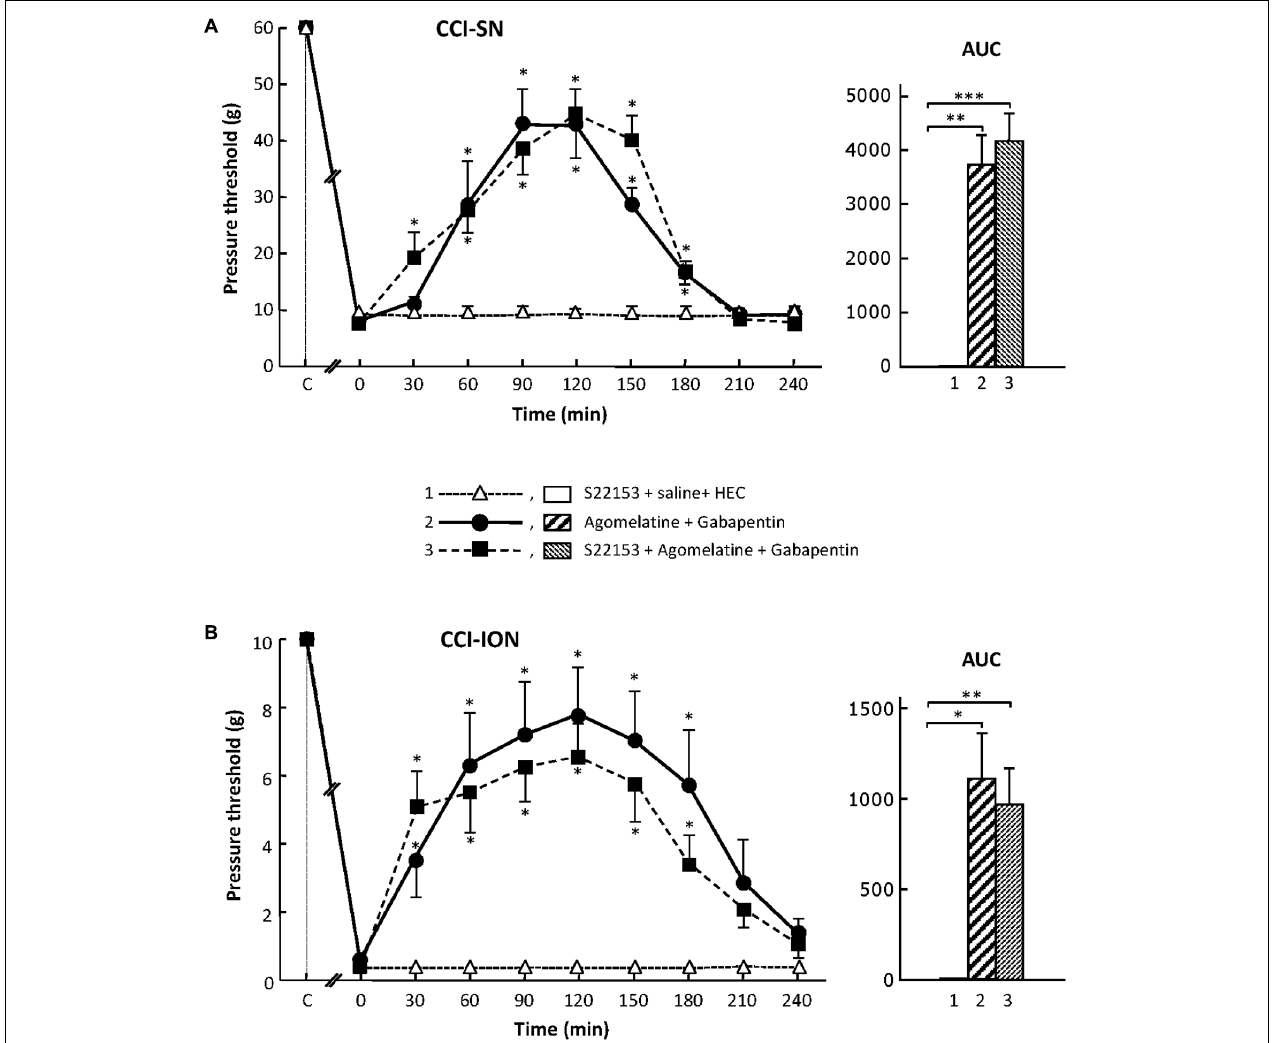
FIGURE 2 | Effect of pretreatment with S22153 on mechanical allodynia inhibition by ‘agomelatine + gabapentin’ in CCI-SN (A) and CCI-ION (B) rats. Left panels: (1) S22153 (20 mg/kg) was injected i.p. 30 min before administration of agomelatine (45 mg/kg i.p.) + gabapentin (50 mg/kg i.p.) – at time 0 on abscissa – in rats whose right SN (A) or ION (B) nerve had been ligated 2 weeks before. Pressure threshold values (as g) were determined as described in the legend to Figure 1 . Each point is the mean ± SEM of n independent determinations. ∗ P < 0.05 compared with pressure threshold values determined just prior to drug injection, one way ANOVA with repeated measures, Dunnett’s test. C on abscissa: intact healthy rats before surgery. In both CCI-SN (A) and CCI-ION (B) rats, ‘saline+HEC’-treated groups were also included, but, for the sake of clarity, corresponding data are not represented as they superimposed with those obtained in rats treated with S22153 plus these vehicles. Right panels: AUC values calculated from the respective time-course curves: (1) S22153 + saline + HEC [ n = 5 (A) , n = 5 (B) ]; (2) agomelatine + gabapentin ( n = 6/7); (3) S22153 + agomelatine + gabapentin ( n = 11/14). A- CCI-SN : one way ANOVA [ F (2,18) = 17.40, P < 0.0001] followed by Tukey’s test ( ∗∗ P < 0.01, ∗∗∗ P < 0.001); B- CCI-ION : one way ANOVA [ F (2,25) = 5.913, P = 0.0079] followed by Tukey’s test ( ∗ P < 0.05, ∗∗ P <